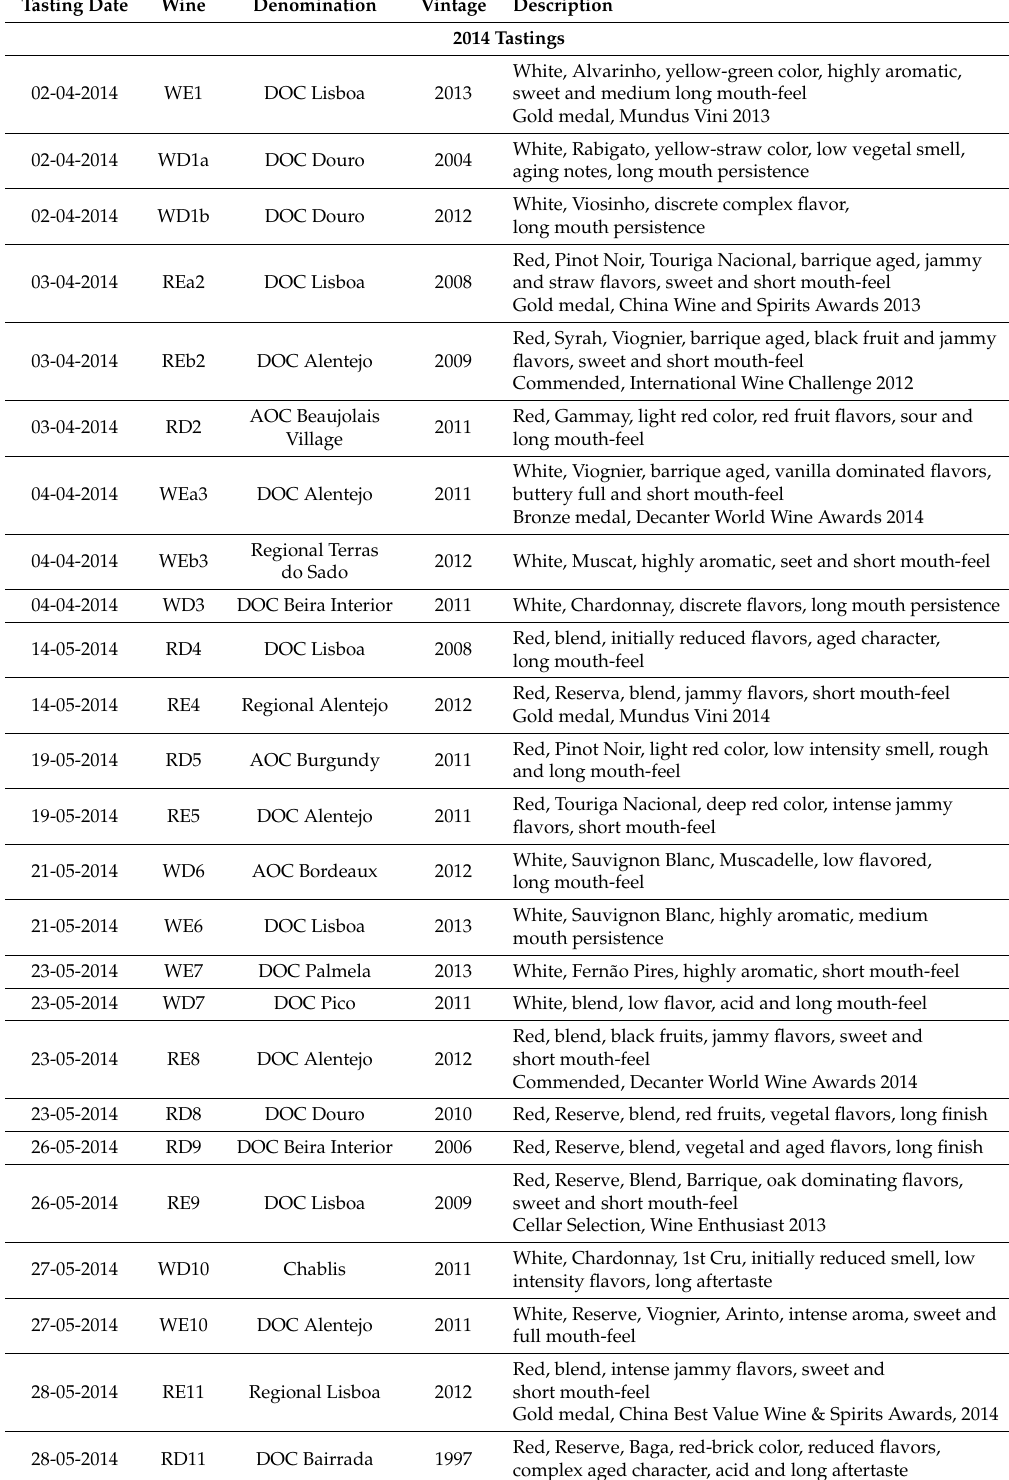
Red, Reserve, Baga, red-brick color, reduced flavors, complex aged character, acid and long aftertaste a Wine reference: W (white), R (red), E (easy), D (difficult), followed by sample number; b DOC: Denomination of Controlled Origin; c AOC: Appelation d’Origine